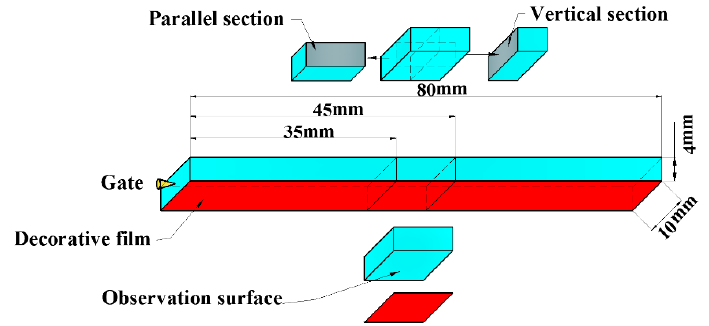
Figure 4. Preparation for vertical and parallel sections and observation surface from flexural sample.